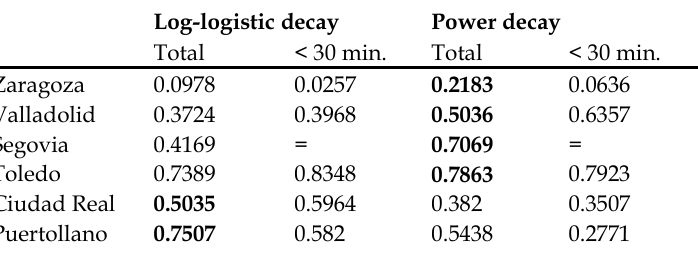
Table 4. Coefficient R 2 of different regressions using log-logistic and power decay functions (dependant variable: users, independent variable: